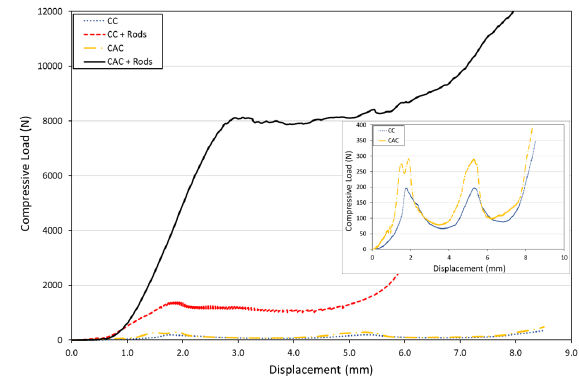
Figure 7: Load-displacement data of panels with two layers of card- board (CC) with and without rods, and two-layers of cardboard and two layers of aluminum in a cardboard-aluminum-cardboard- aluminum stacking structure (CACA) with and without rods.